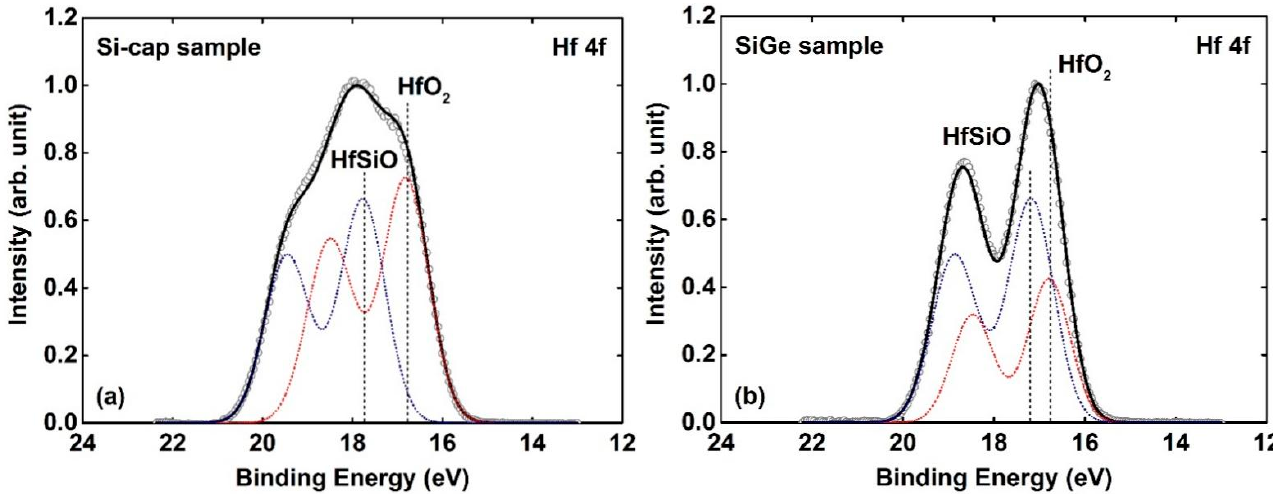
Figure 6. The fitted Hf 4f core ‐ level spectra of ( a ) Si ‐ cap sample and ( b ) SiGe sample. The blue and red dot lines denote the Hf 4f photoelectron from Hf ‐ O ‐ Si and/or Hf ‐ O ‐ Ge bonds and Hf ‐ O bonds in HfO 2 , respectively.